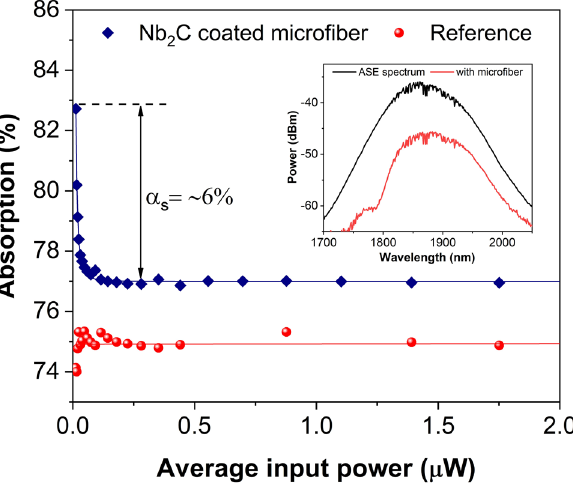
Figure 4. Nonlinear absorption curves of reference sample (without Nb 2 C coating) and Nb 2 C coated microfiber. Inset shows the spectral transmittance of microfiber prior to the Nb 2 C